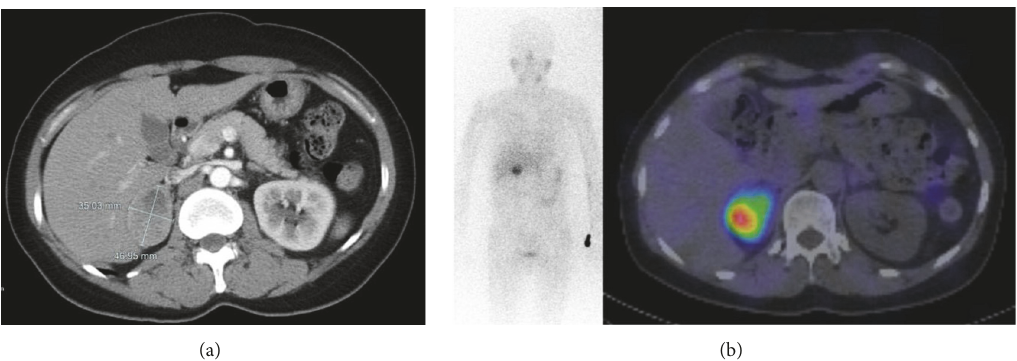
Figure 1: (a) Abdominal computed tomography showing a heterogeneous enhanced mass in the right adrenal gland. (b) Image generated by scintigraphy and single-photon emission computed tomography showing the right adrenal mass and demonstrating increased uptake of metaiodobenzylguanidine.